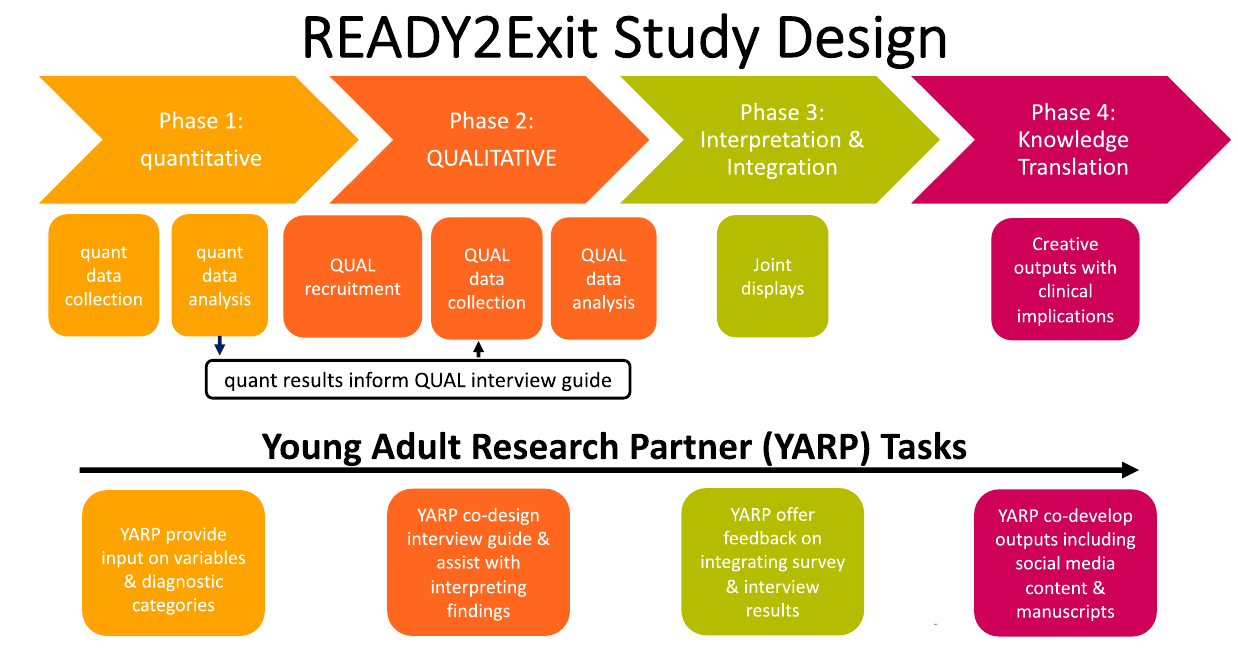
Figure 1: READY2Exit study design & young adult research partner tasks. quant, quantitative; QUAL, QUALITATIVE (capitalization denotes priority); YARP, young adult research